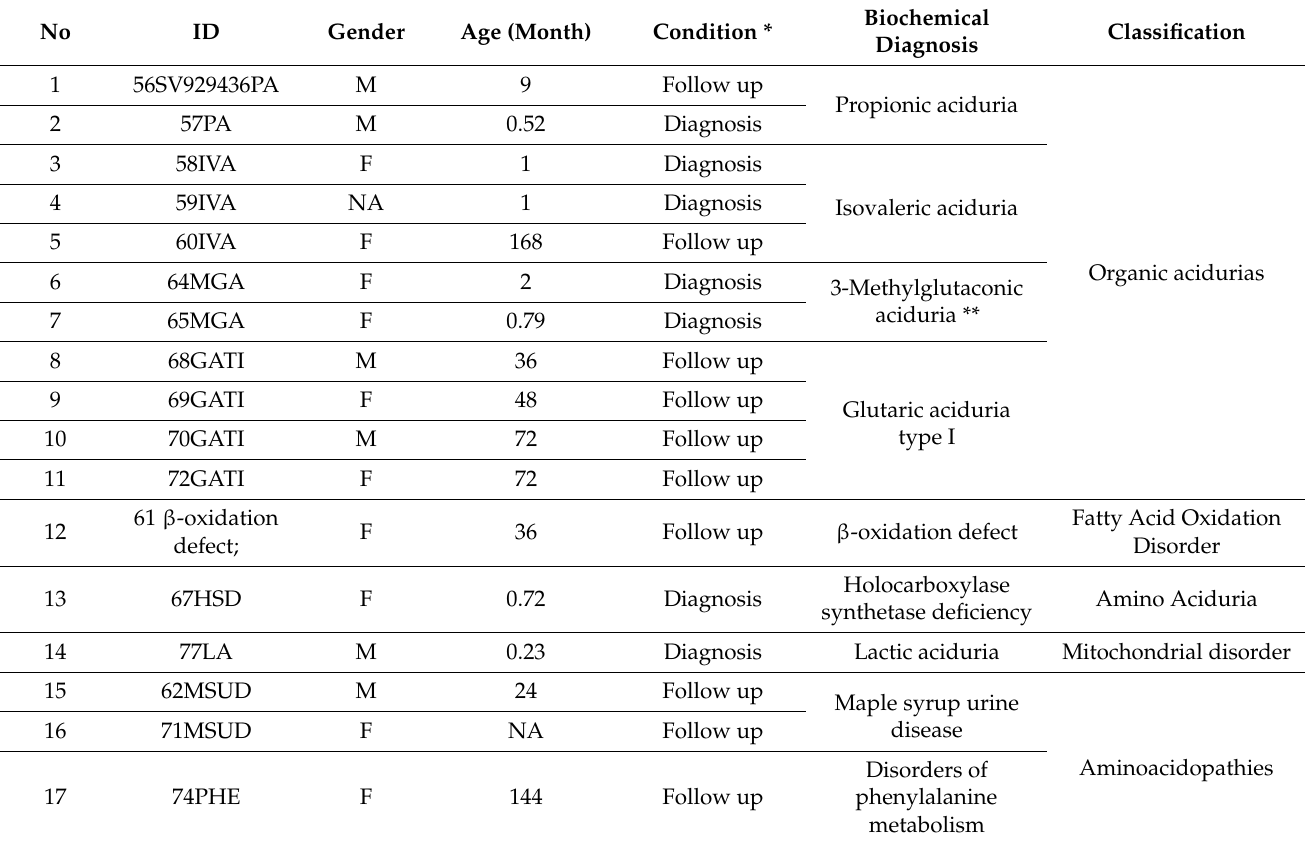
Table 4. Characteristics of affected